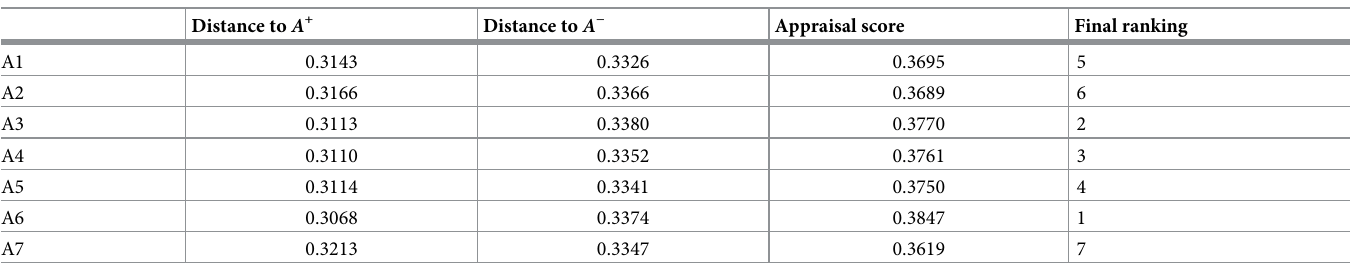
Table 13. Comparative analysis